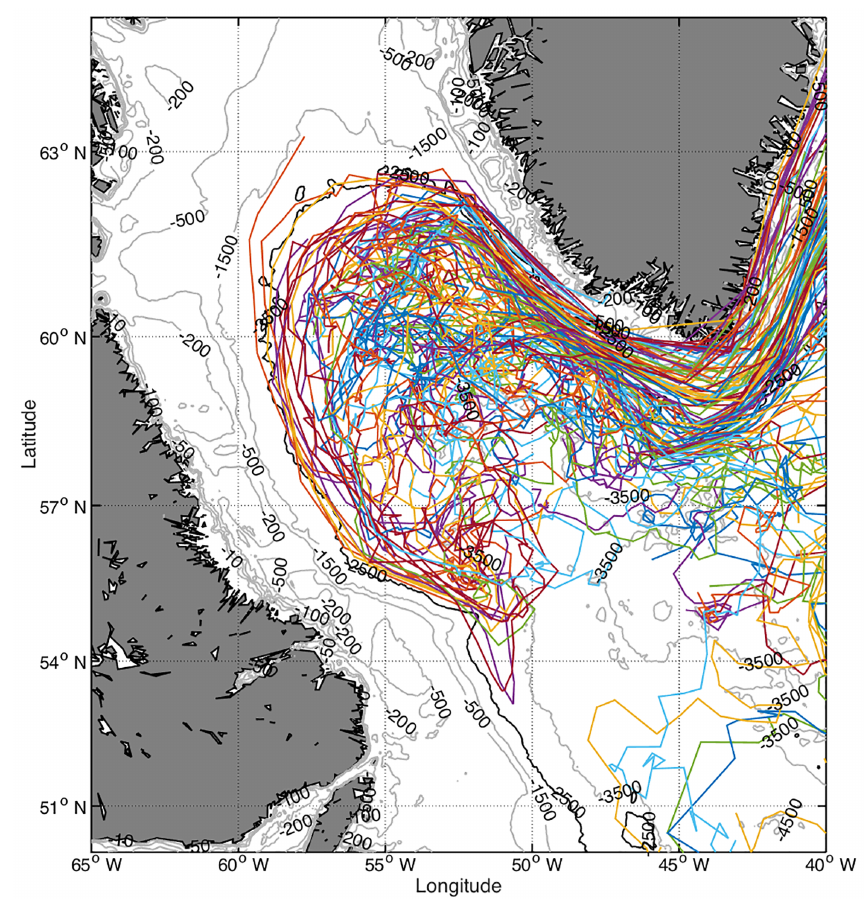
Figure 3. Trajectories of 0.01% of the 205929 trajectories that entered the basin. The trajectories were chosen randomly and are shown in a different color each. Bathymetry is contoured in gray at 500m intervals with the 2500m isobaths in